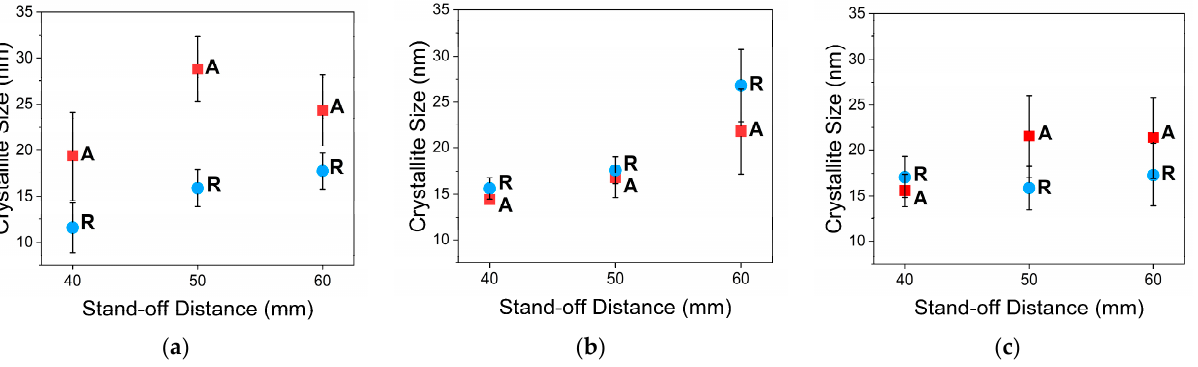
Figure 10. Calculated anatase (A) and rutile (R) crystallite sizes for ( a ) FS1, ( b ) FS2, and ( c ) FS3